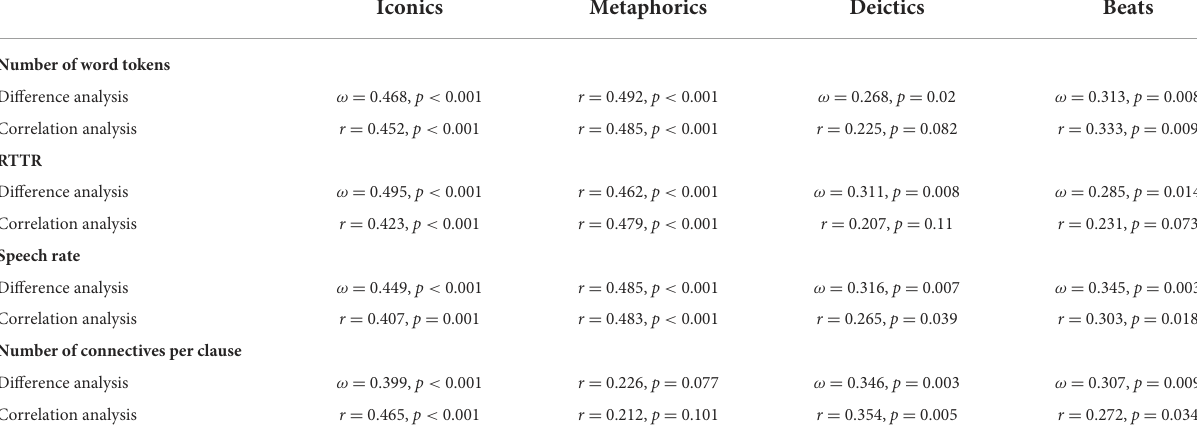
TABLE 11 Effect sizes and p values for associations between four types of co-speech gestures and meaning and discourse-related speech measures. Iconics Metaphorics Deictics